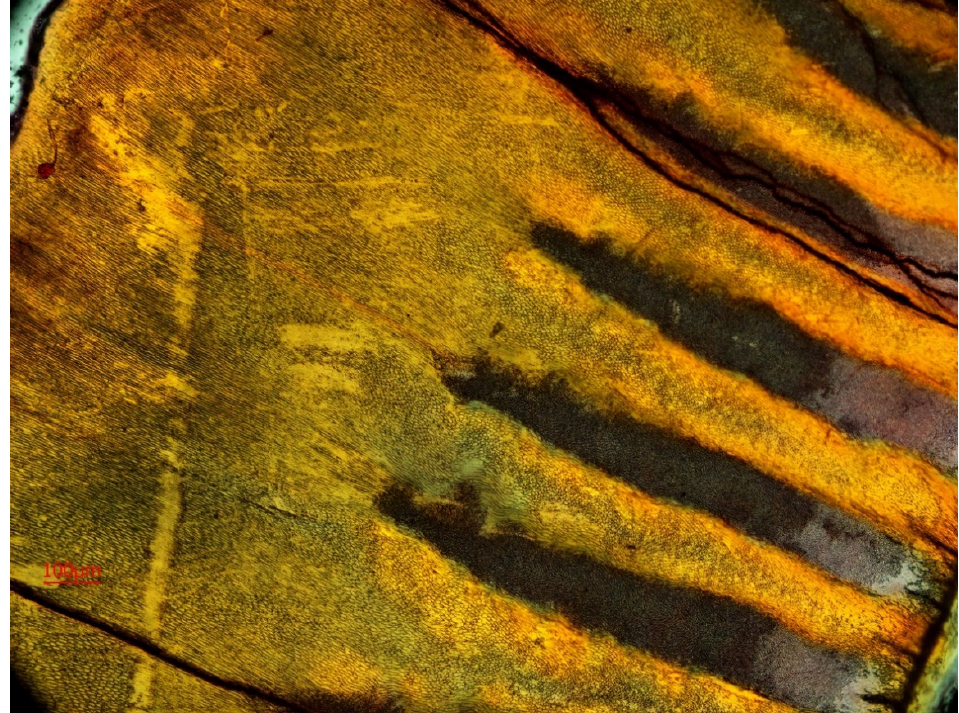
Figure 12. Image of enamel (horizontal section through the crown) on the third premolar (P 3 ) of the white rhinoceros female under light microscope using polarization.